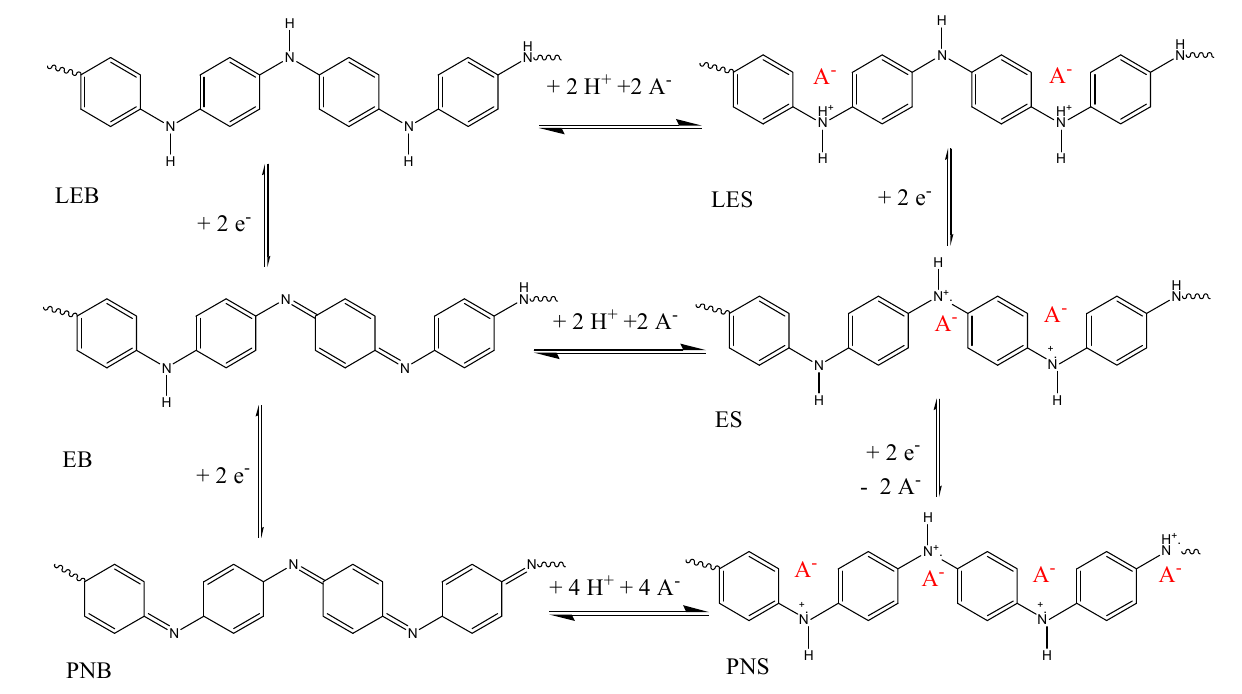
Scheme 2. Different forms of PANI, which are interconverted by oxidation/reduction or protona-